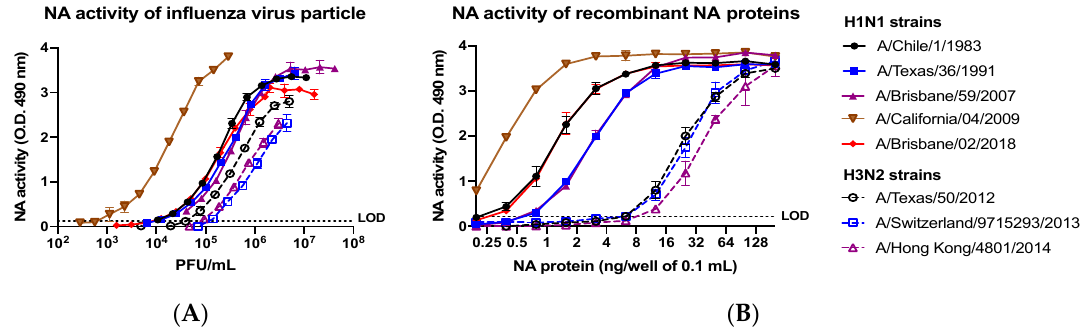
Figure 8. Neuraminidase activity of: wild-type influenza A virus ( A ); and the corresponding recombinantly expressed and purified NA proteins from stably-transfected cell lines ( B ). Recombinant NA proteins from H1N1 strains and H3N2 strains were evaluated for neuraminidase activity measured as the ability to cleave sialic acid displayed on the fetuin glycoprotein. LOD represents the limit of